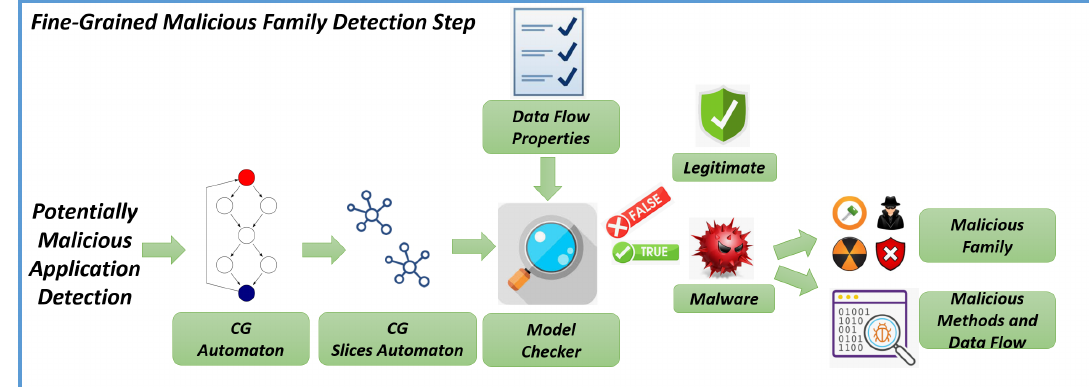
Figure 2. Fine-grained malicious family detection step. Figure 1. Potentially malicious application detection